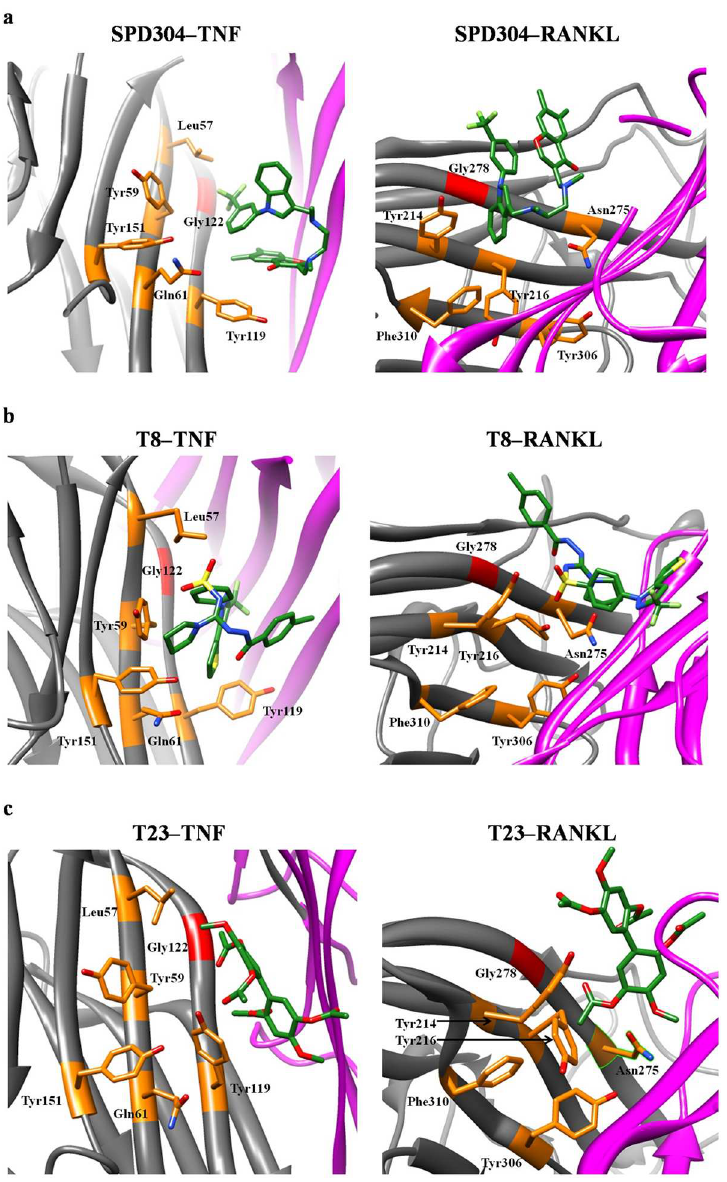
Fig 6. Representative MD conformations of (a) SPD304, (b) T8 and (c) T23 in TNF and RANKL complexes. Important residues for protein inhibitionare displayedin orange; Gly122 and Gly278 are shown in red. Protein chains A and B are colored gray and magenta, respectively. For simplicity, interacting residues only on chains A are displayedand hydrogenatoms are not shown. Compoundsare highlighted in